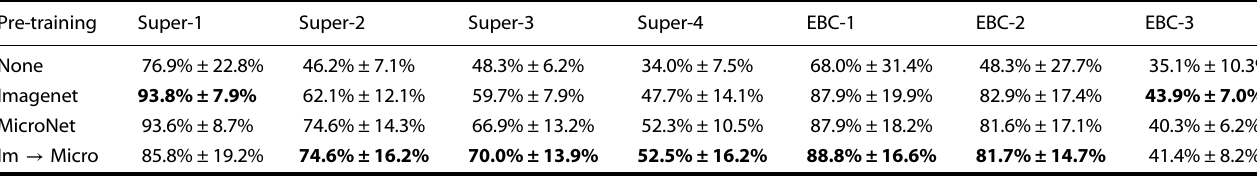
Table 2. Average performance of models initialized with different pre-training weights for each experiment.